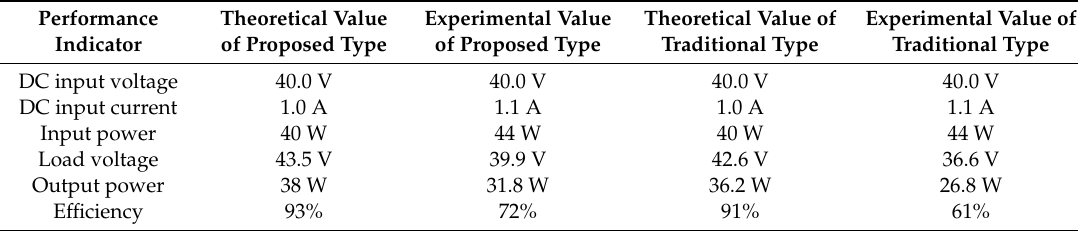
Table 8. Comparison of two types of WPT